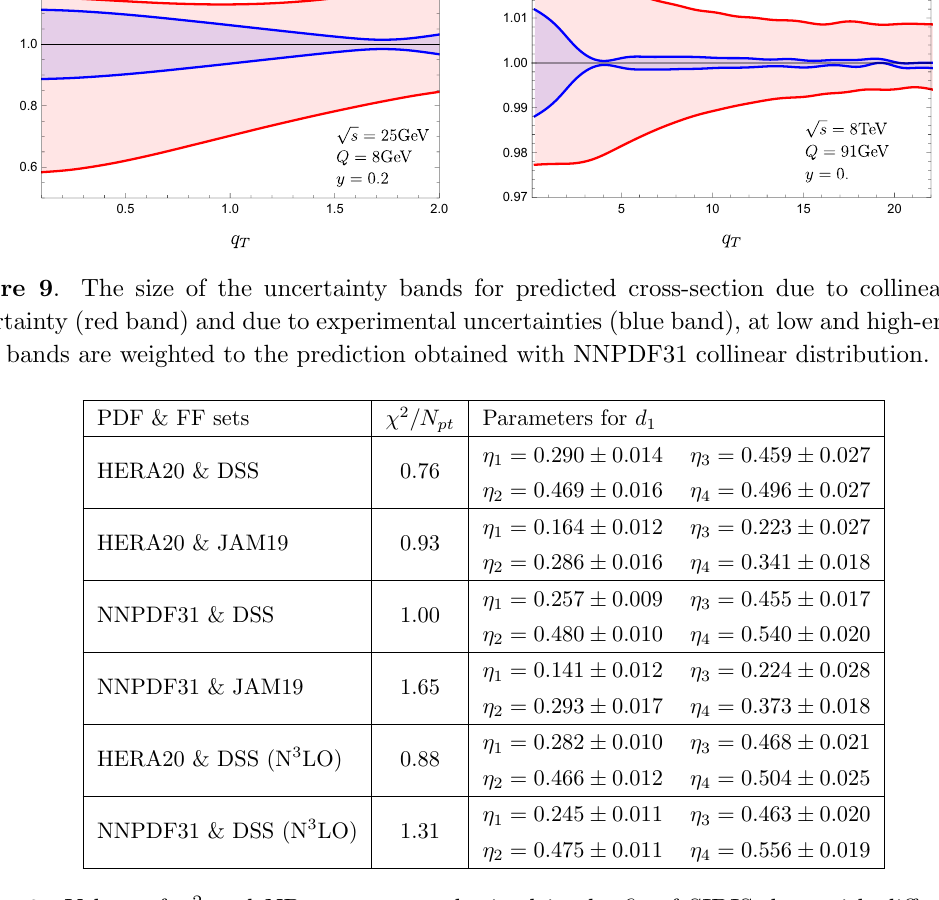
Table 6 . Values of (cid:31) 2 and NP parameters obtained in the (cid:12)t of SIDIS data with di(cid:11)erent FF inputs. The TMD evolution parameters and TMDPDF parameters are (cid:12)xed from the (cid:12)t of DY data (see table 5), and labeled by the PDF set. The visual presentation of this table is given in (cid:12)gure